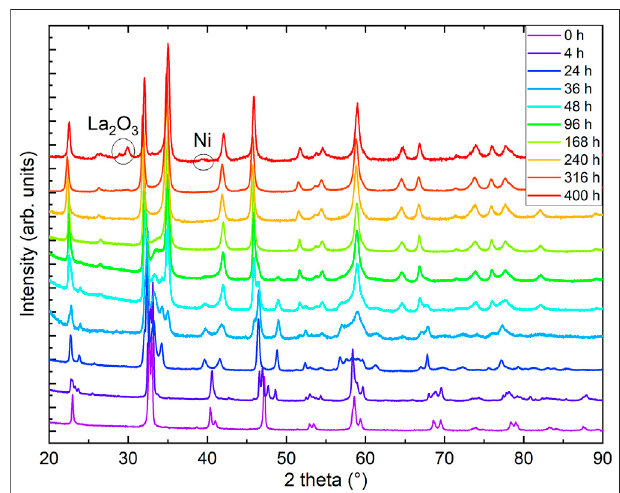
FIGURE 1 | Powder x-ray diffraction (PXRD) of reduced LaNiO 3 after different reduction times. Data were measured at T = 300 K with Cu K α radiation. Curves are offset in vertical direction for clarity. The 0- and 316-h data are reproduced from Ref.